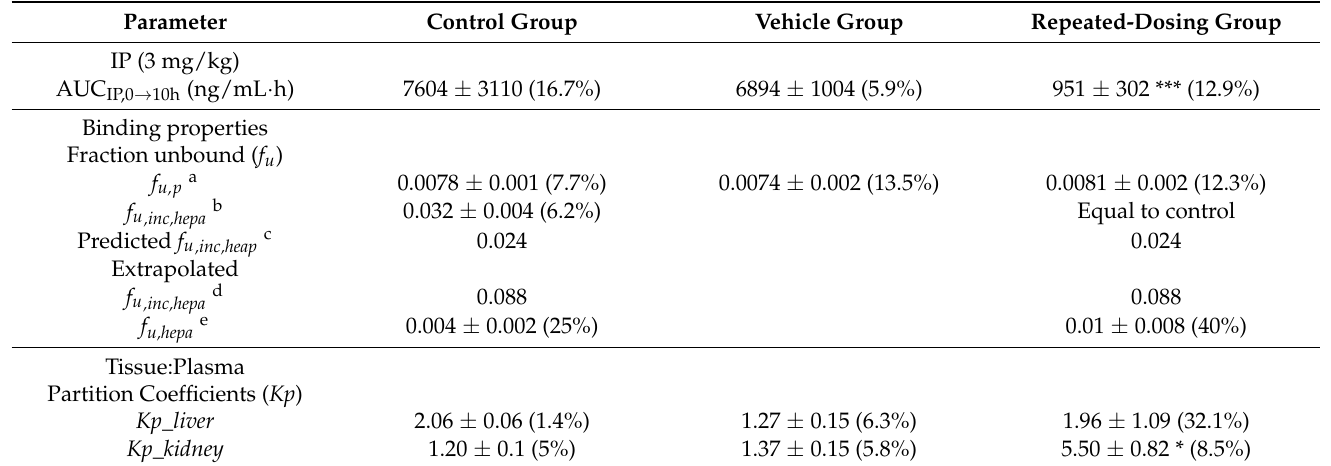
Figure 2. ( a , b ) Mean plasma concentration–time curve of SCR430 after IV ( a ) or IP ( b ) administration at a dose of 3 mg kg − 1 ( △ , control (without a dosing vehicle or SCR430) group; □ , vehicle (vehicle only, 14 days, PO) group; ● , repeated-dosing (SCR430 30 mg/kg, 14 days, PO) group ( n = 6). ( c – e ) Comparison of the control, vehicle, and repeated-dosing groups’ pharmacokinetic parameters. The AUC from time 0 h to infinity (AUC 0– ∞ ) ( c ), the total plasma clearance (CL) ( d ), and the steady-state volume of distribution (Vd ss ) ( e ) were compared. A one-way ANOVA statistical analysis was used for the statistical analysis, followed by a Turkey’s post-hoc test, where appropriate. The stars indi- cate statistical significances, ** p < 0.01, *** p < 0.001.